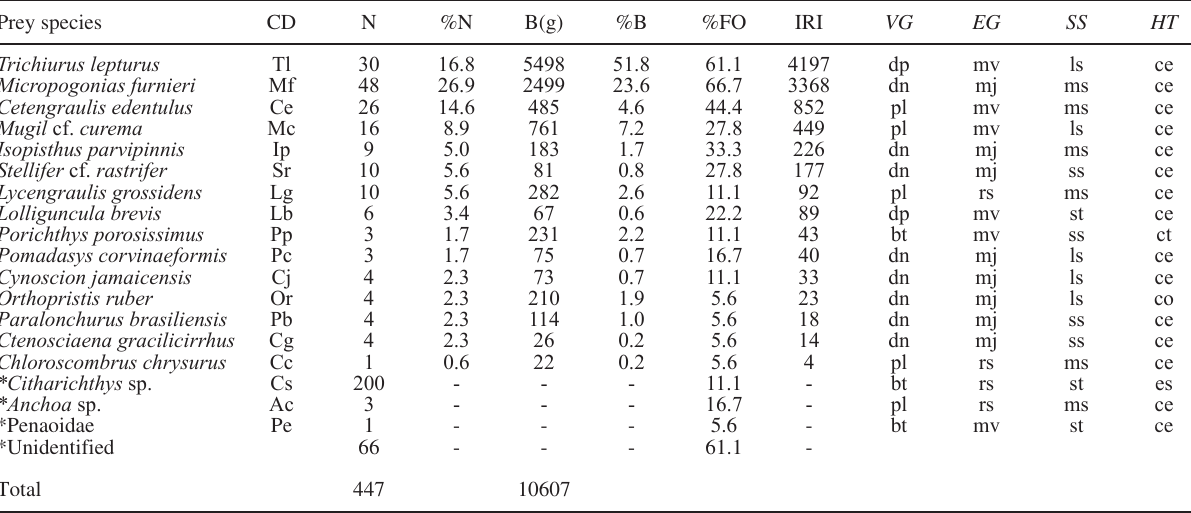
Table 1. – Descriptive parameters of prey importance in the diet of the Guiana dolphin from Norte Bay. Abbreviations: Individual number (N), percentage number (%N), frequency of occurrence (FO), percentage of frequency of occurrence (%FO), biomass (B), percentage of biomass (%B), Index of Relative Importance (IRI), not calculated (-); Prey codes (CD), vertical guilds ( VG ), ecological guild ( EG ), size of schools ( SS ) and habitat type ( HT ) – see the significance of codes throughout the text. Prey